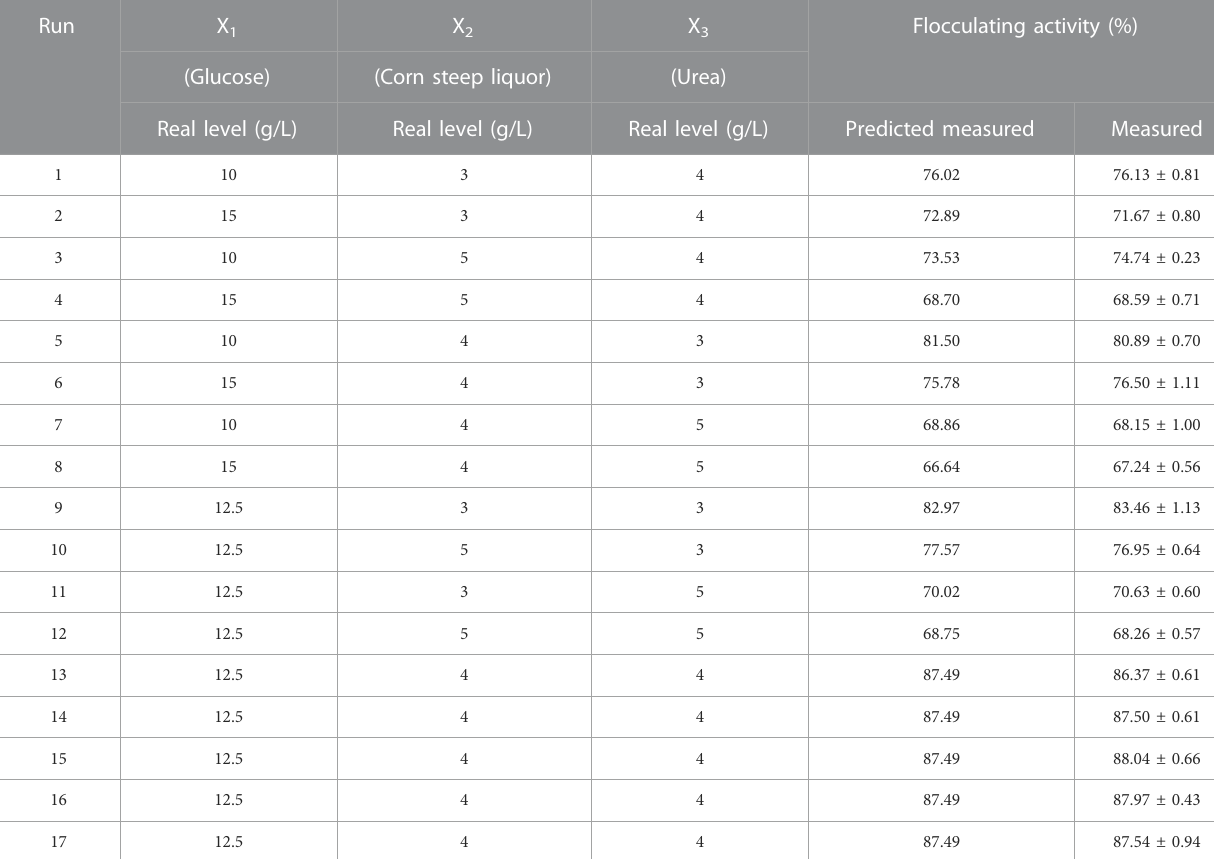
TABLE 1 The matrix of the BBD experiment for culture medium optimization and the experimental and predicted fl occulating activity.